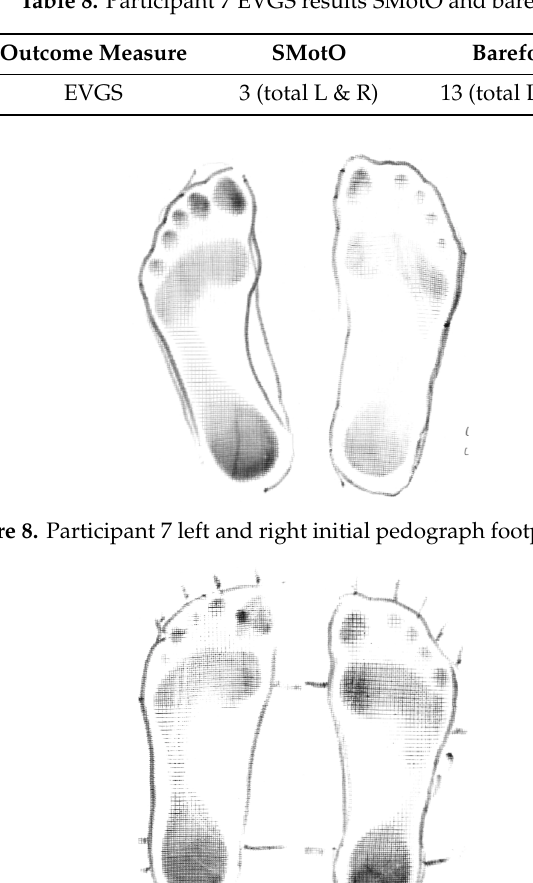
Table 8. Participant 7 EVGS results SMotO and barefoot.